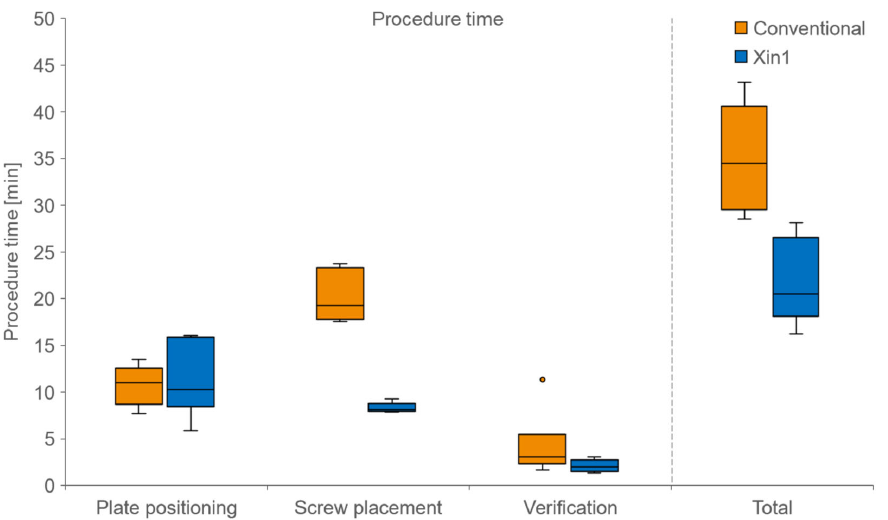
Figure 4. Procedure time for the conventional method versus Xin1 for three phases during the operation and in total time.